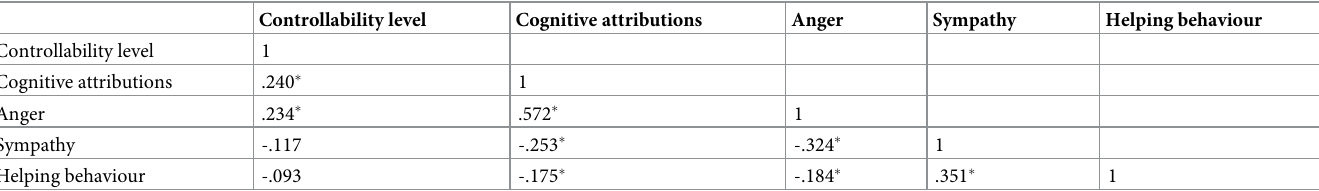
Table 3. Pearson correlations (r) for the four reliable scales of MDRS and the controllability